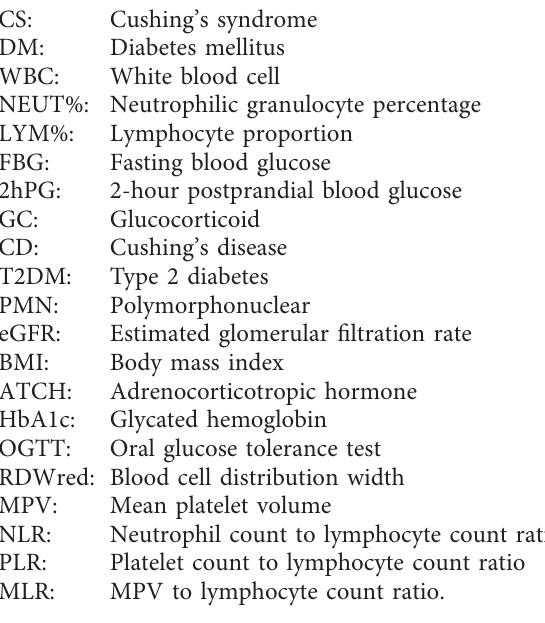
Supplementary Figure 1: flow diagram of the study. Sup- plementary Table 1: associations between predictors and diabetes mellitus (UNIANOVA analysis). ( Supplementary Materials